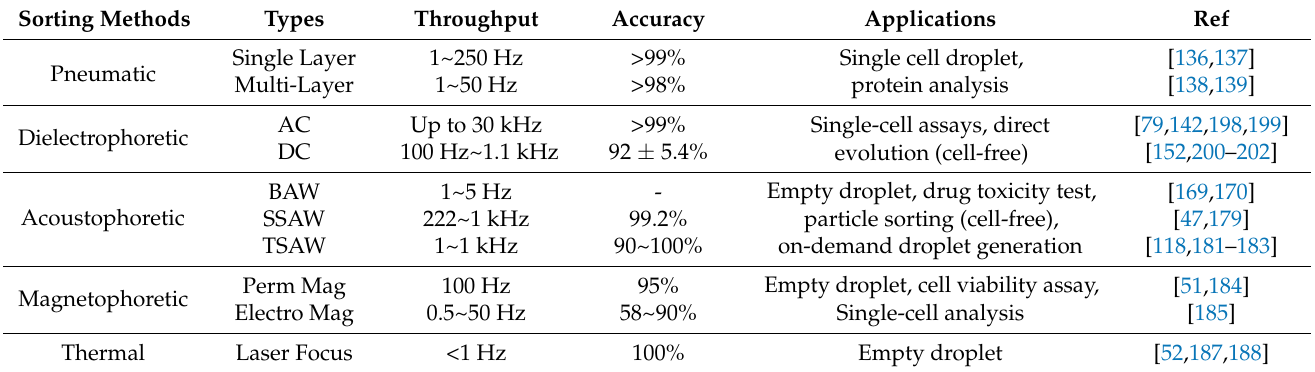
Table 2. Summary of all reviewed sorting methods and their critical performance